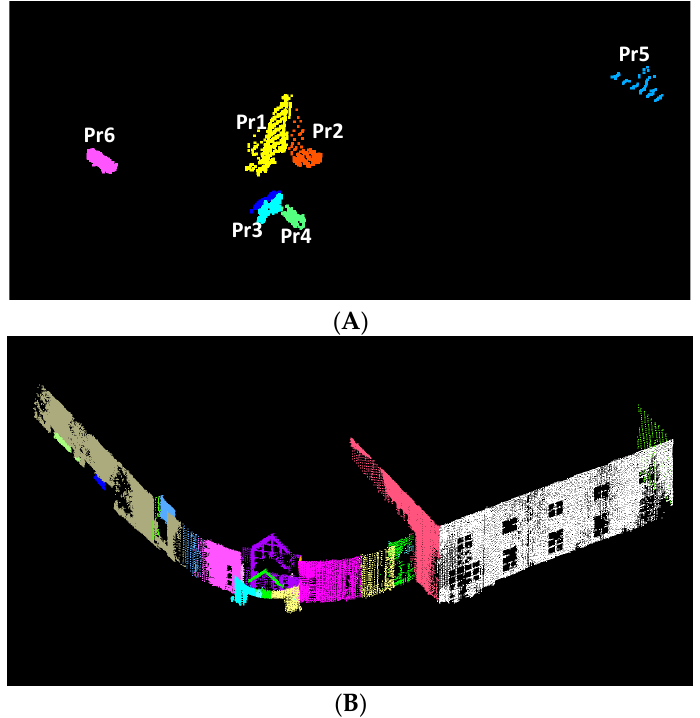
Figure 16. Recognition of roof and roof shape ( A ); and wall ( B ) from point cloud.